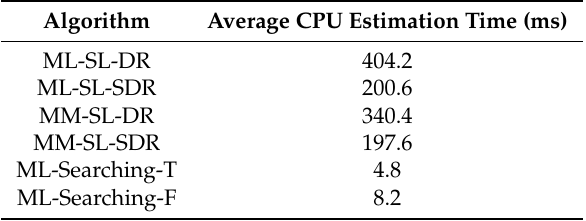
Table 1. Average CPU estimation time for different source localization algorithms for sensor